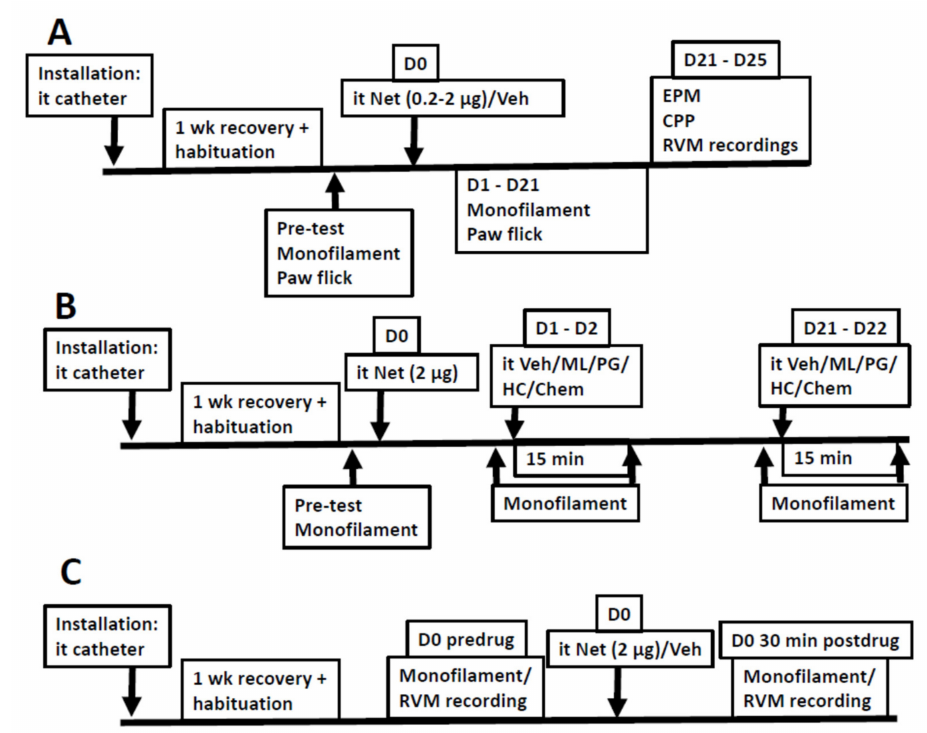
Figure 6. Schematic time course of the experimental procedures when assessing basic characteristics of the prolonged hypersensitivity ( A ), reversal of hypersensitivity ( B ), and acute hypersensitivity ( C ). Chem = Chembridge-5861528; CPP = conditioned place preference; D0–D21 = Day of testing; EPM = elevated plus maze; HC = HC-070; it = intrathecal; ML = ML-204; Net = Netrin-1; PG = Pregabalin; RVM = rostral ventromedial medulla; Veh =